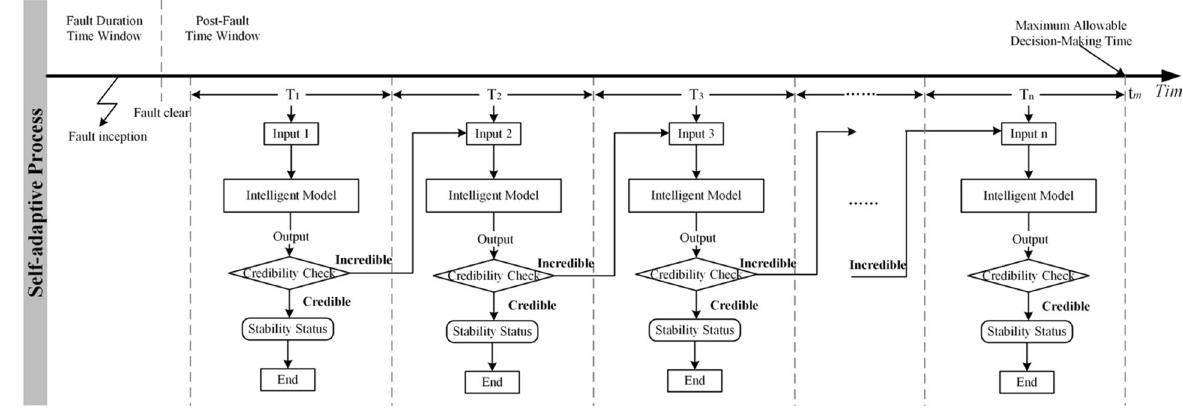
Fig. 2 Structure of the Self-Adaptive TSA